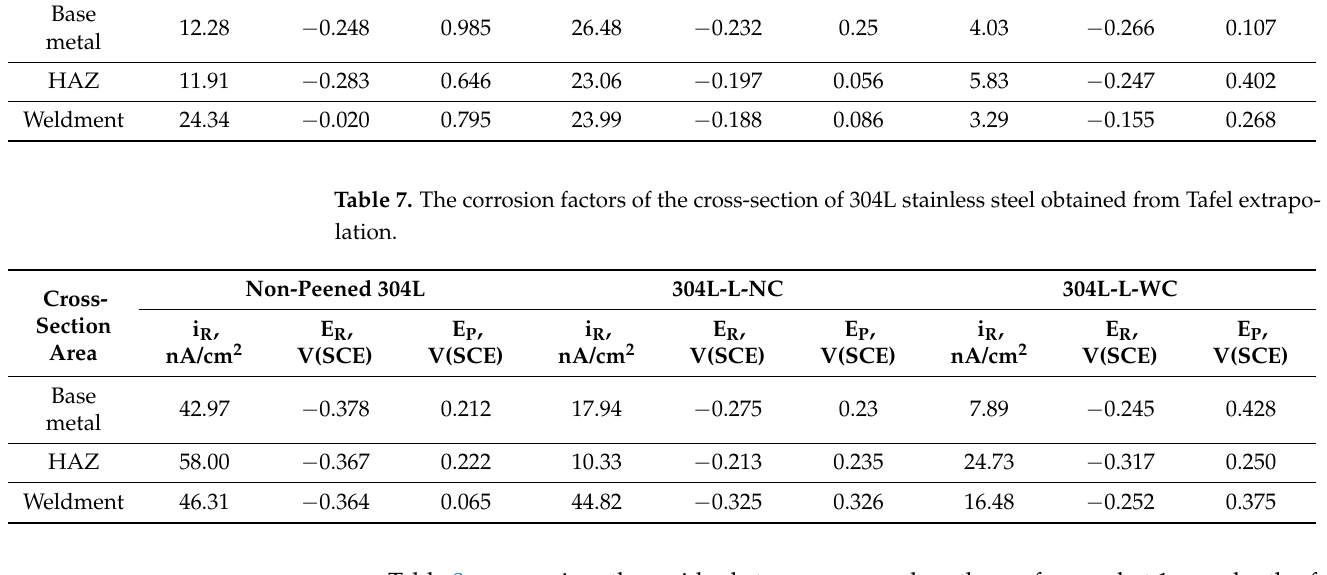
Table 8 summarizes the residual stress measured on the surface and at 1 mm depth of 304L stainless steel via a hole drilling method: The surface and 1 mm depth of non-peened 304L stainless steel showed tensile residual stress, but compressive residual stress of the peened specimen was formed, regardless of measuring